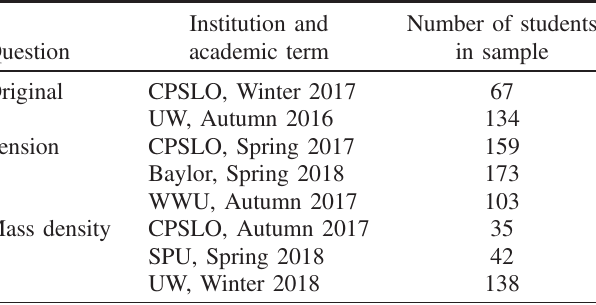
TABLE I. Administration contexts and participation rates for three versions of the pulse-flick question. For all samples, participation was least 70% of students enrolled in the